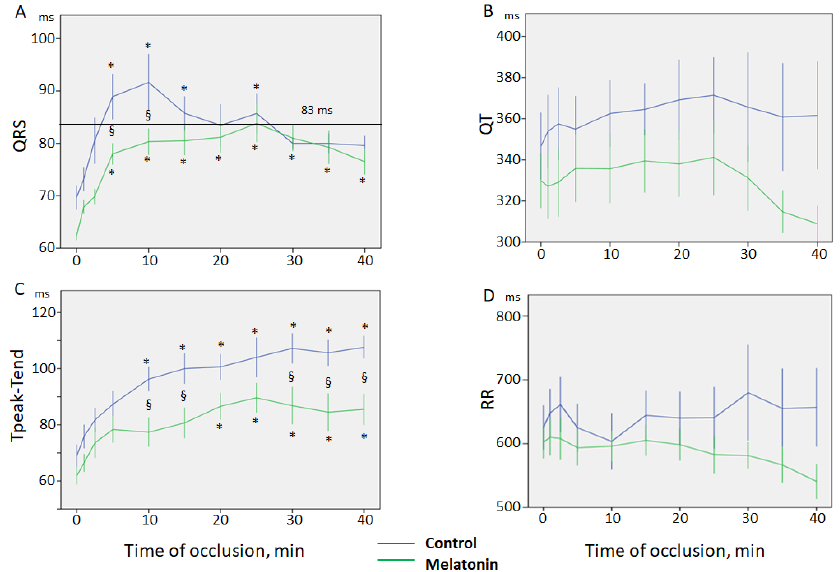
Figure 1. Dynamics of ECG parameters during coronary occlusion in control and melatonin groups (mean ± SEM). ( A ) QRS interval; note two peaks of QRS prolongation at 5–10th and 25th mins. In the melatonin group, the early phase of QRS prolongation is blunted. 83 ms cut-off point of QRS for VF development. Note that QRS duration does not exceed the cut-off point of 83 ms in the melatonin-treated animals; ( B ) QT interval; ( C ) Tpeak-Tend interval; ( D ) RR interval; *- p < 0.05 differences in respect to baseline state (0 min); §- p < 0.05 differences between control and melatonin groups.